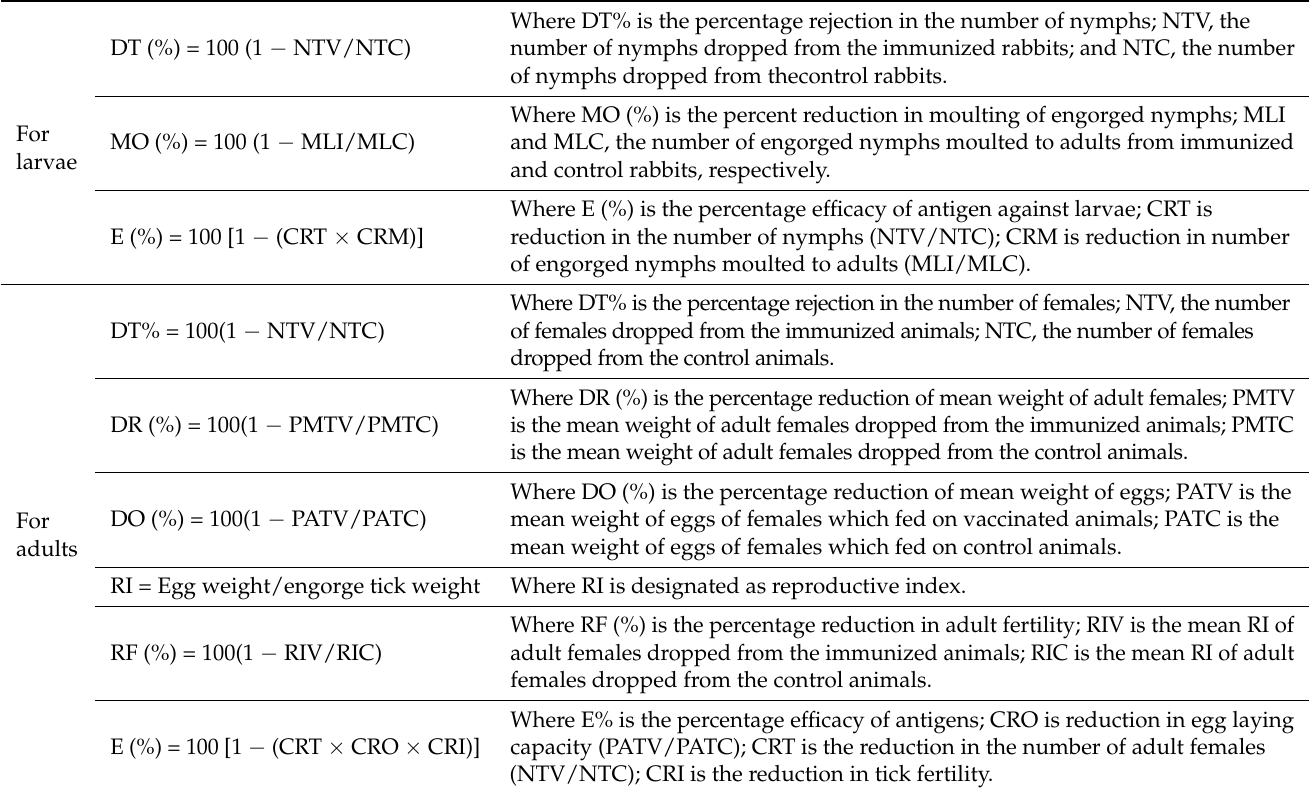
Table 2. Formula of determination of vaccine efficacy against Hyalomma anatolicum